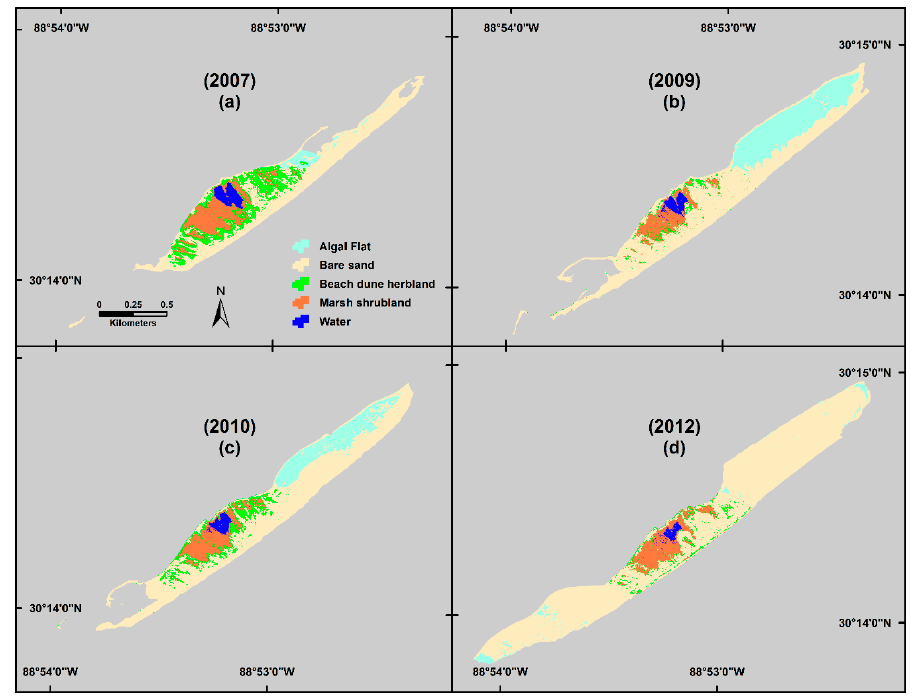
Figure 2. Maximum Likelihood classifications of East Ship Island for the years: ( a ) 2007; ( b ) 2009; ( c ) 2010; and ( d ) 2012.